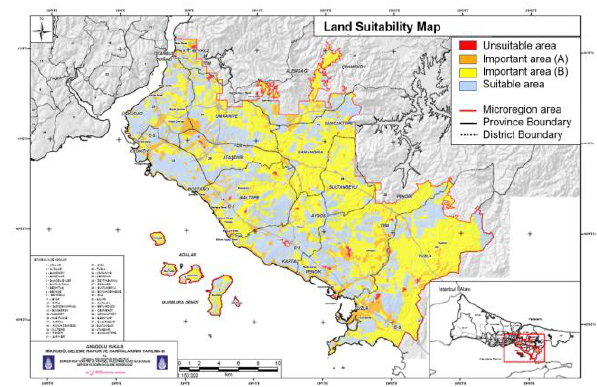
Figure 2. Land suitability map produced by the IMM for the microregion of Anatolian side in